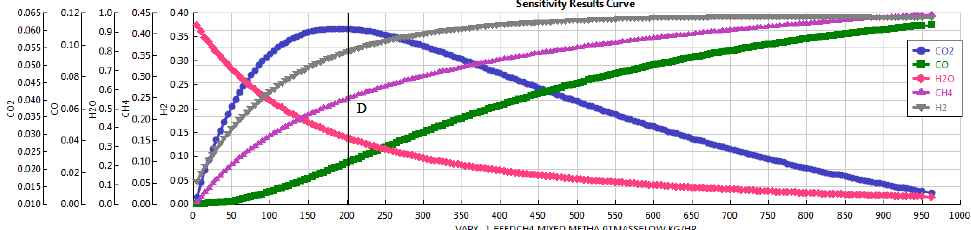
Figure 3. SMR sensitivity results (SMR molar fractions vs CH 4 feed). Line D corresponds to the CH 4 flow rate of 200 (kg/h).